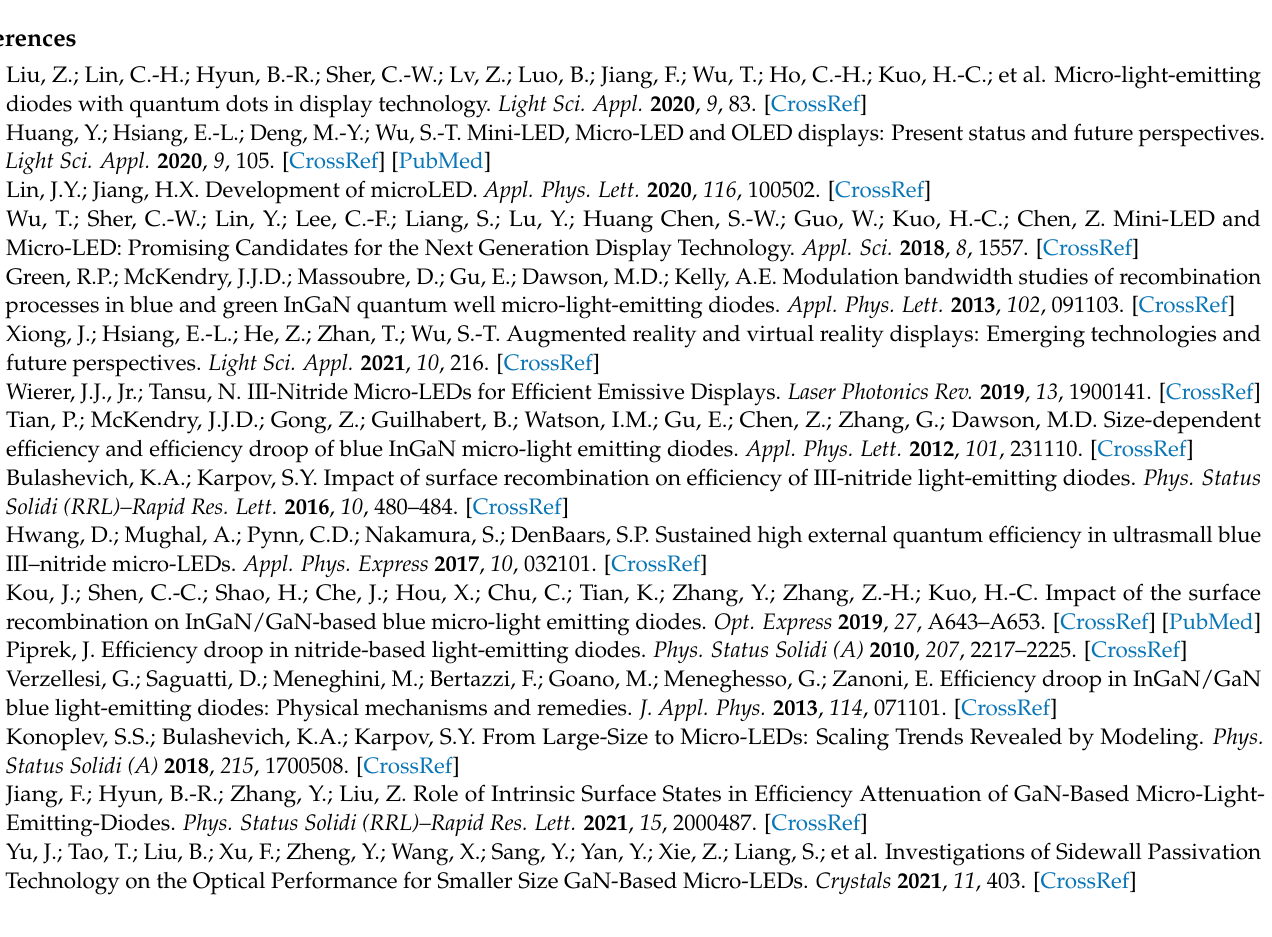
Figure A5. EQE and WPE curves of Micro-LEDs of S1, S2, and S3 for ( a ) 30 × 30 μ m and ( b ) 60 × 60 μ m; ( c ) 100 × 100 μ m.